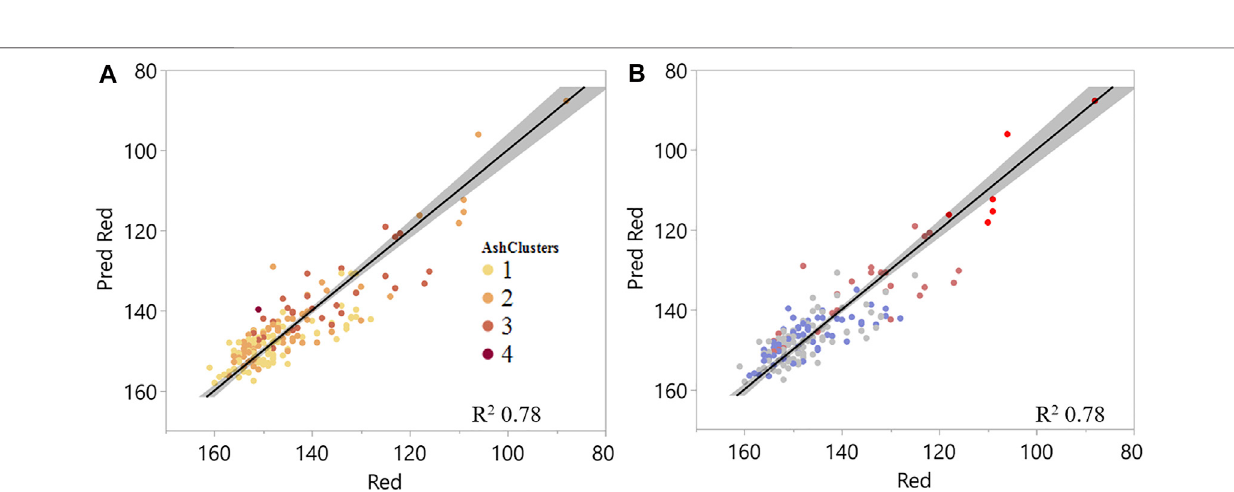
Frontiers in Energy Research |